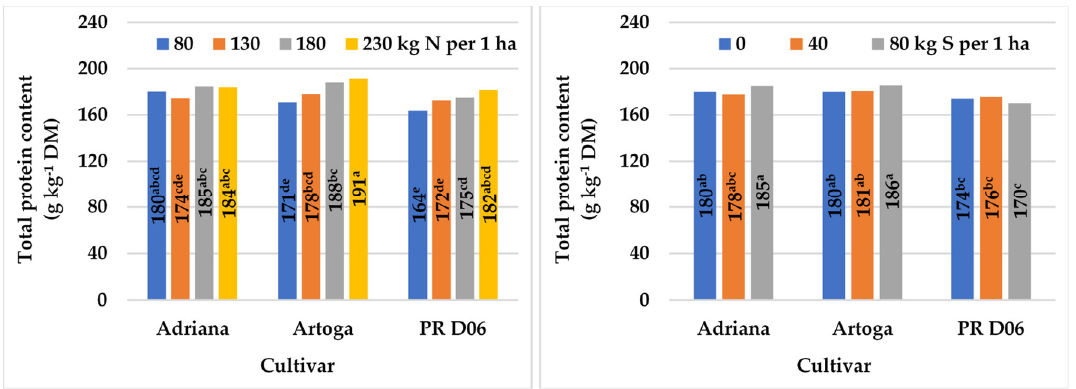
Figure 12. The effect of N and sulfur (S) rates on the total protein content of winter oilseed rape seeds, across years. Means with the same letters do not differ significantly at p ≤ 0.05 in Tukey`s test.